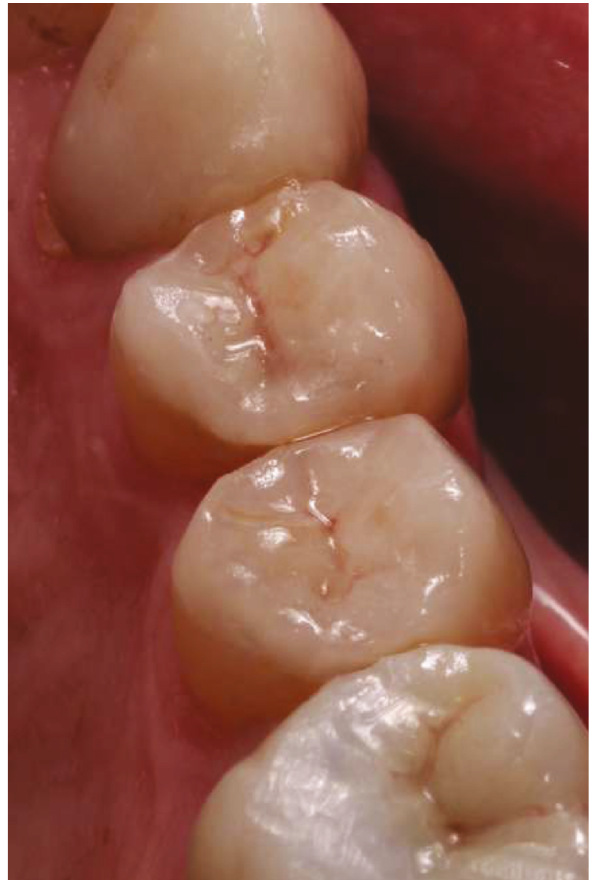
Figure 10: Maxillary left occlusal view after cementation of lithium disilicate restorations.